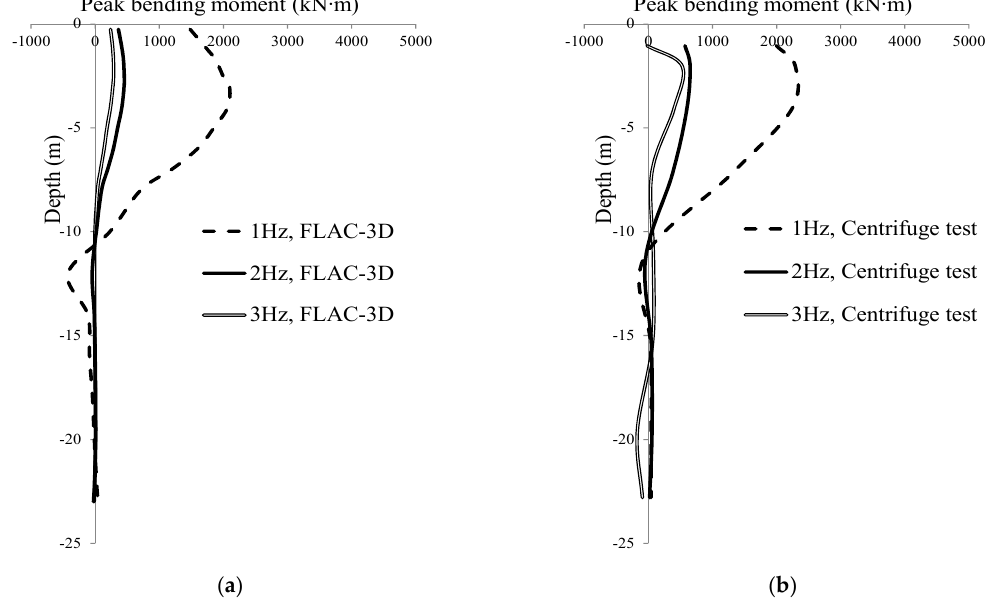
Figure 6. Measured and calculated peak bending moment profiles under input acceleration of 0.13 g (Model 1, sinusoidal wave): ( a ) Calculated by proposed model; ( b ) Measured by experiment.